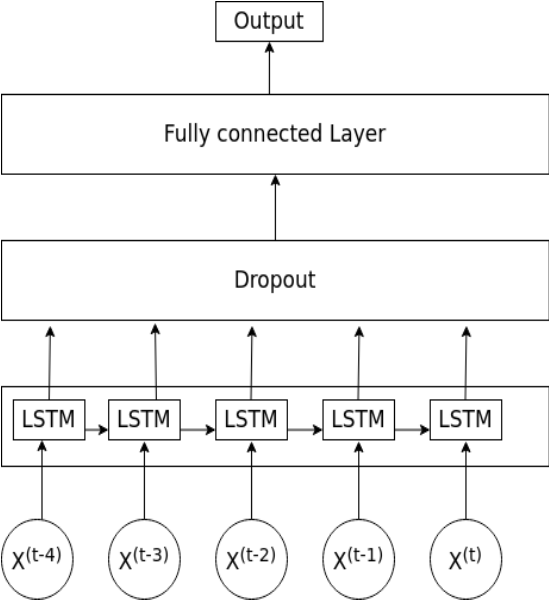
Figure 6. The proposed LSTM